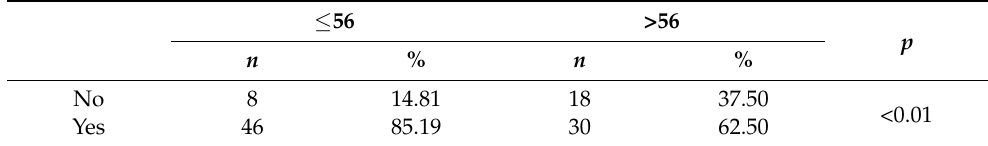
Table 7. Patient age and the CPI determination.